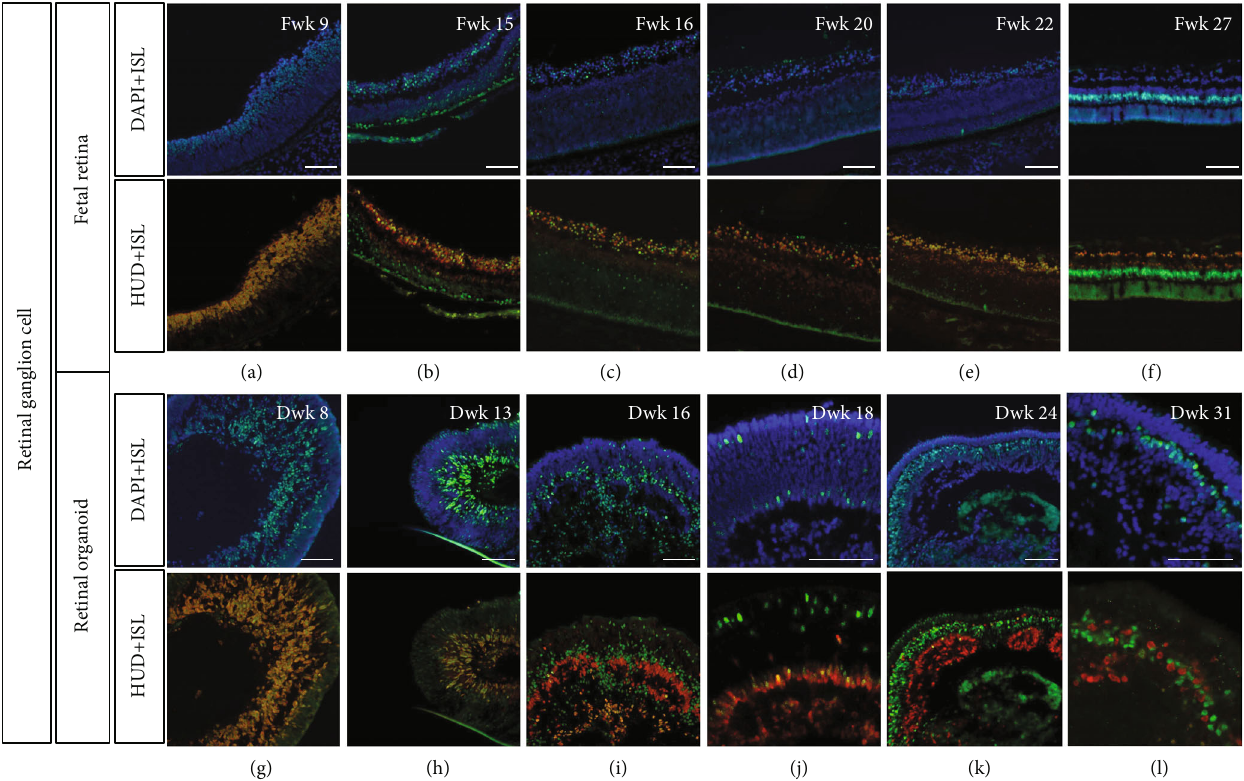
Figure 3: Double immunolabeling of Islet1 and HuD in human fetal retinal and retinal organoid. (a – f) HuD coexpressed with Islet1 in GCL during the early stage of fetal retina development. From Fwk 16, a subpopulation of HuD-positive and Islet1-negative amacrine cells appeared in the INL. (g – l) HuD showed a similar expression pattern in retinal organoids. From Dwk 24, double-positive cells disappeared, and only HuD-single-positive amacrine cells organized as rosettes in the retinal organoid ( scale bar = 100 μ m